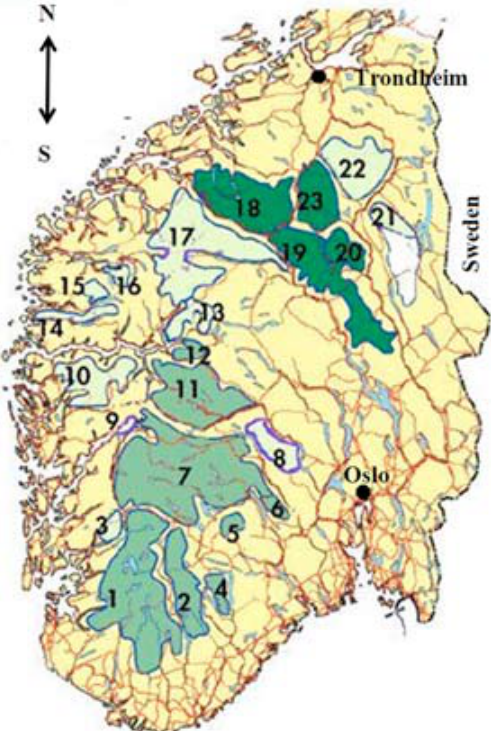
Fig. 1. Map of South Norway with Hardangervidda (no. 7), Rondane (no. 19) and other wild rein- deer areas in Norway. (Source: The Norwe- gian Wild Reindeer Council/Villreinrådet i Norge, http://www.villreinen.no/Villreinrå-